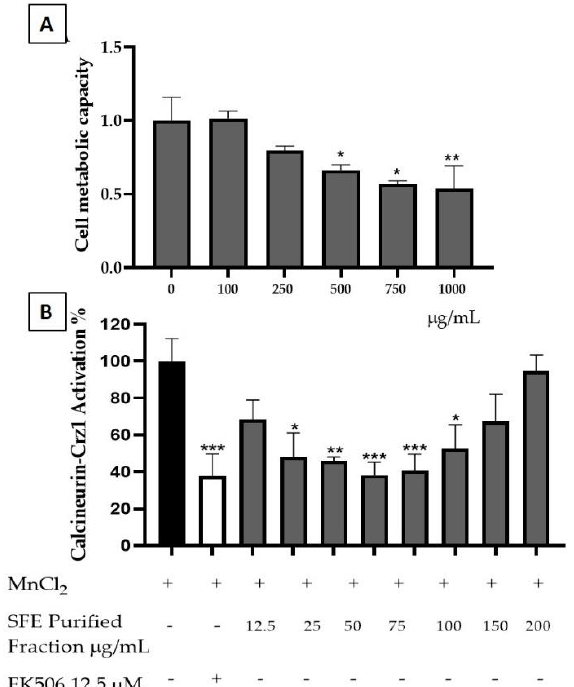
Figure 8. SFE extract potential for inhibiting calcineurin/Crz1 activation. ( A ) Toxicity of SFE extract was evaluated at the indicated concentrations of SFE in µg/mL. ( B ) Anti-inflammatory potential of SFE extract as demonstrated by the inhibi- tion of the calcineurin/Crz1 pathway in S. cerevisiae . Statistical differences are noted as * p < 0.1 , ** p < 0.01, *** p < 0.001 relative to the activated control (cells treated with MnCl 2